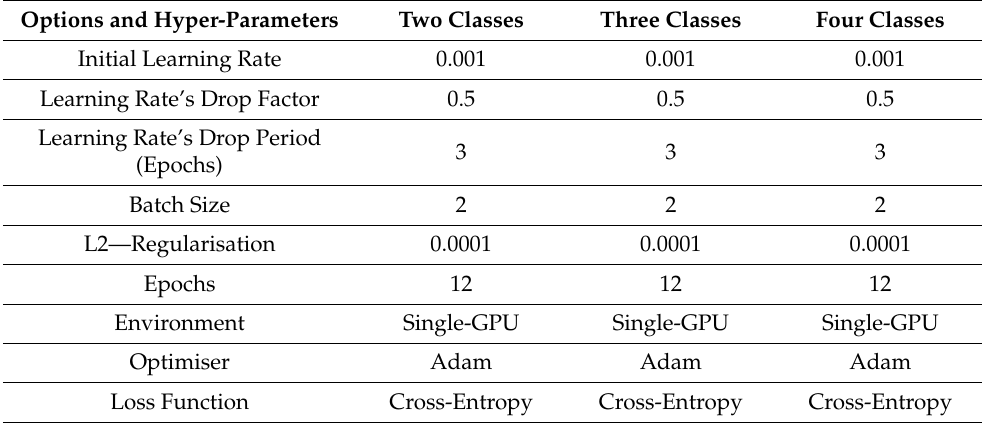
Table 7. Hyperparameters and training options for the X3D